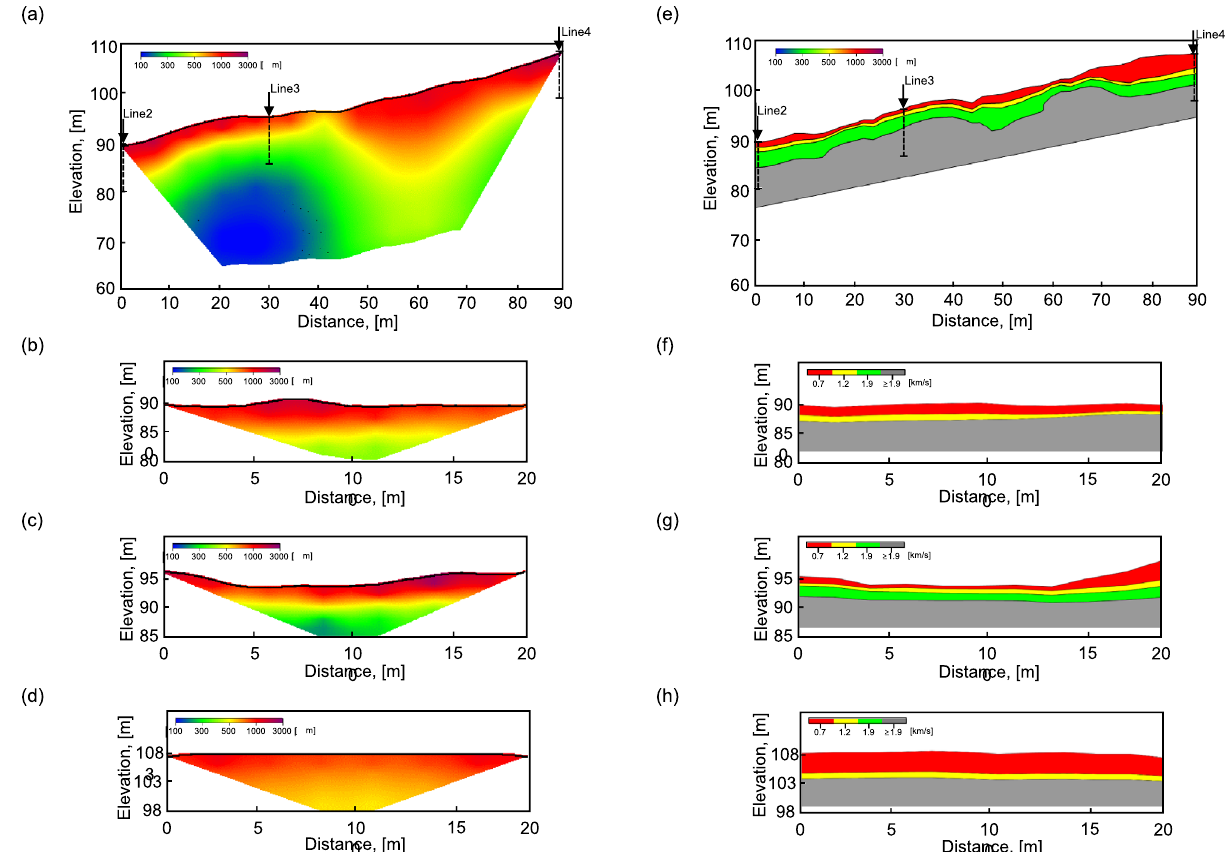
Figure 4. Geophysical survey results: ( a ) line 1; ( b ) line 2; ( c ) line 3; ( d ) line 4 for electrical resistivity ( e ) line 1; ( f ) line 2; ( g ) line 3; ( h ) line 4 for elastic